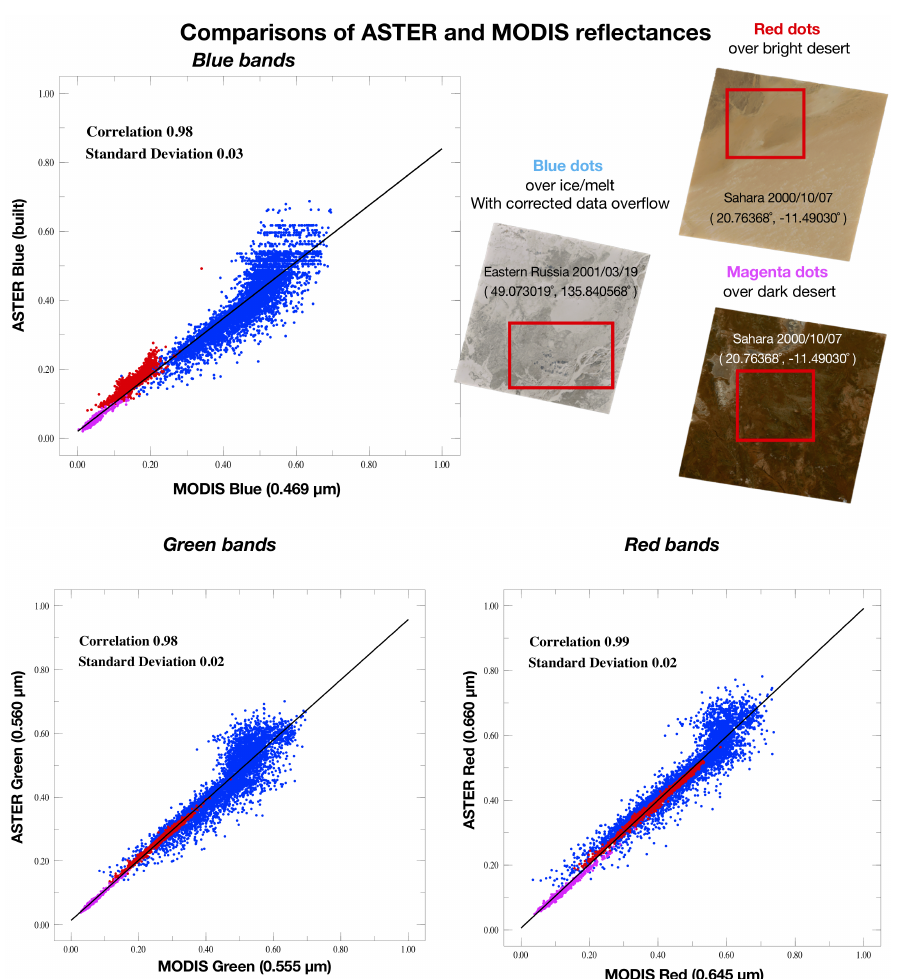
Figure 10. Correlations between ASTER and MODIS reflectance values for the red, green and blue bands, across several surfaces (selected within the red boxes), as ice/melt areas (blue dots), bright desert areas (red dots), and dark desert areas (magenta dots).